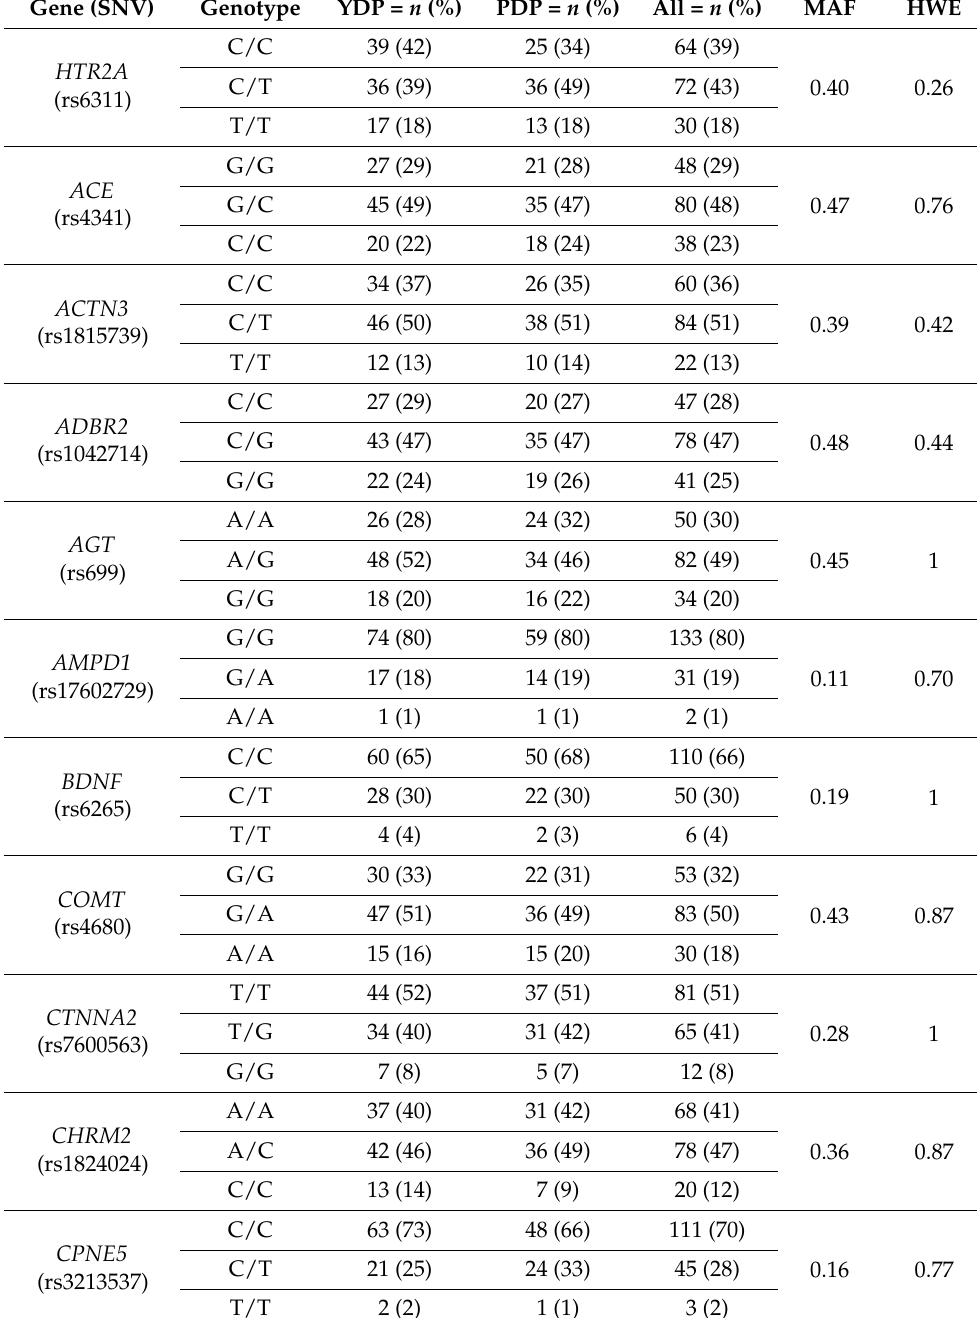
Table 2. Descriptive statistics of youth and professional development phase English academy football